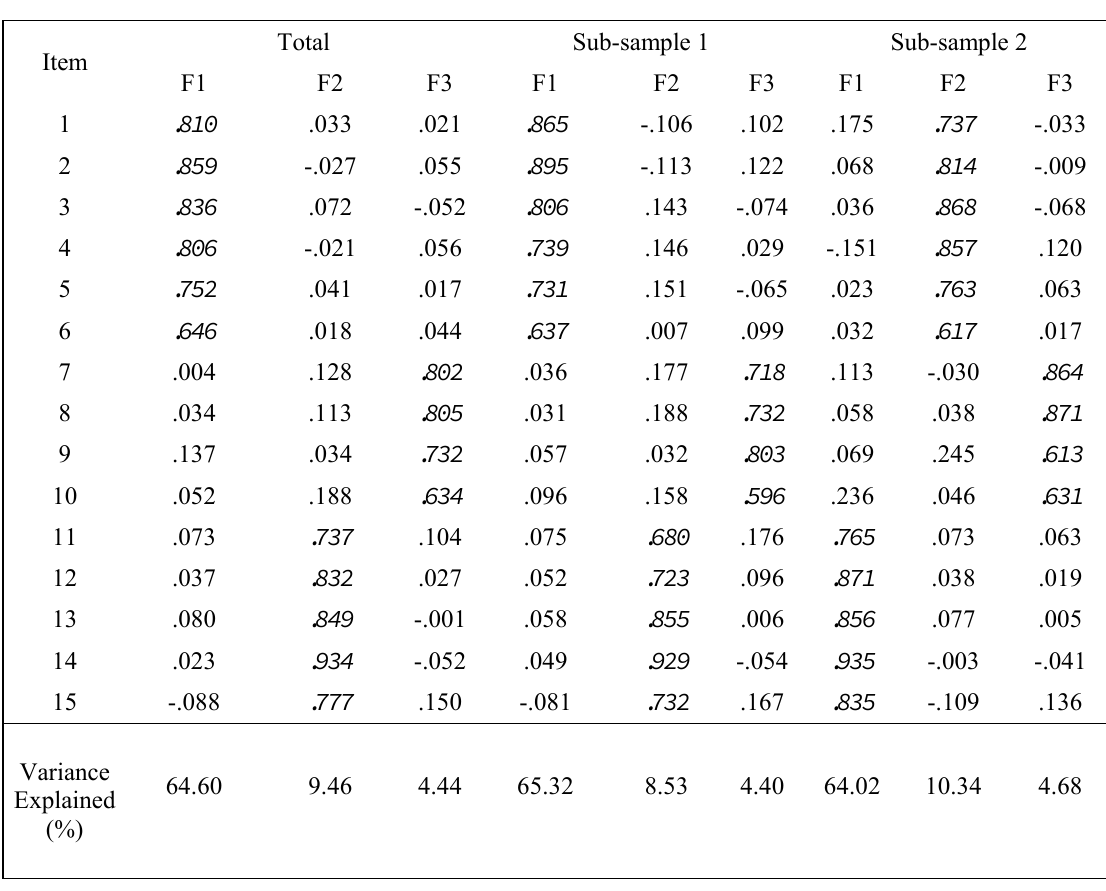
Factor pattern matrix (alpha extraction followed by Promax) of the Subjective Outcome Scale